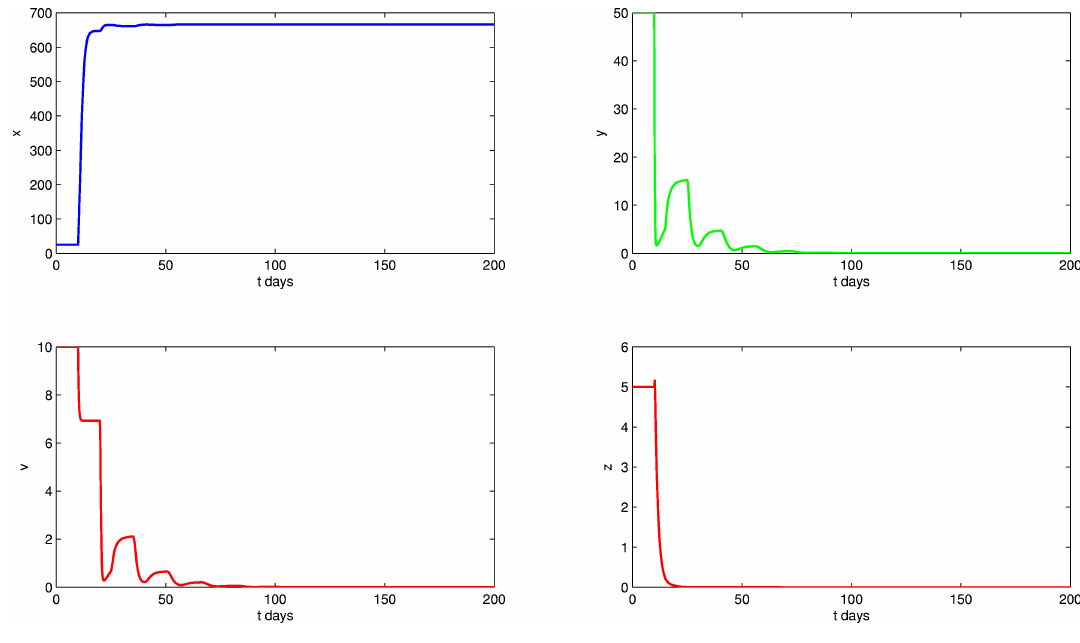
Fig. 1. Global stability of infection free equilibrium for R 0 < 1 .